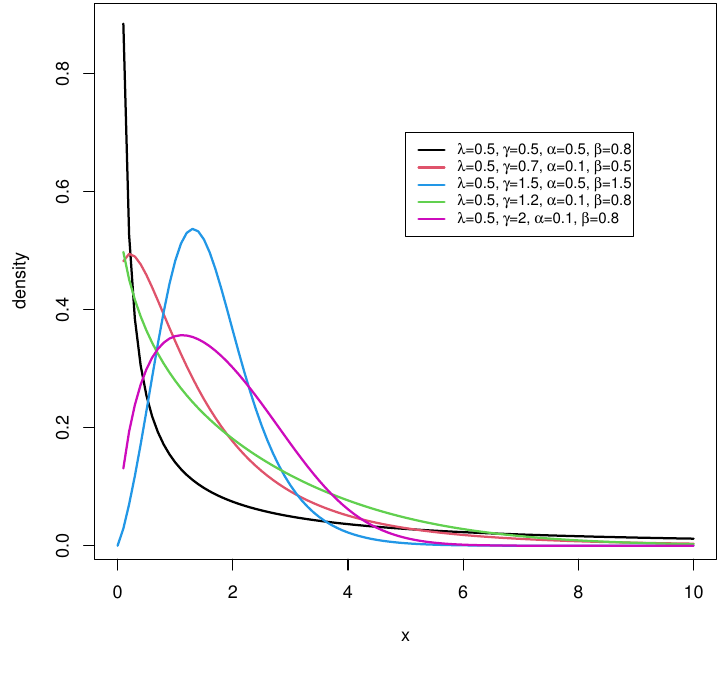
Figure 2. Plots of the pdf in